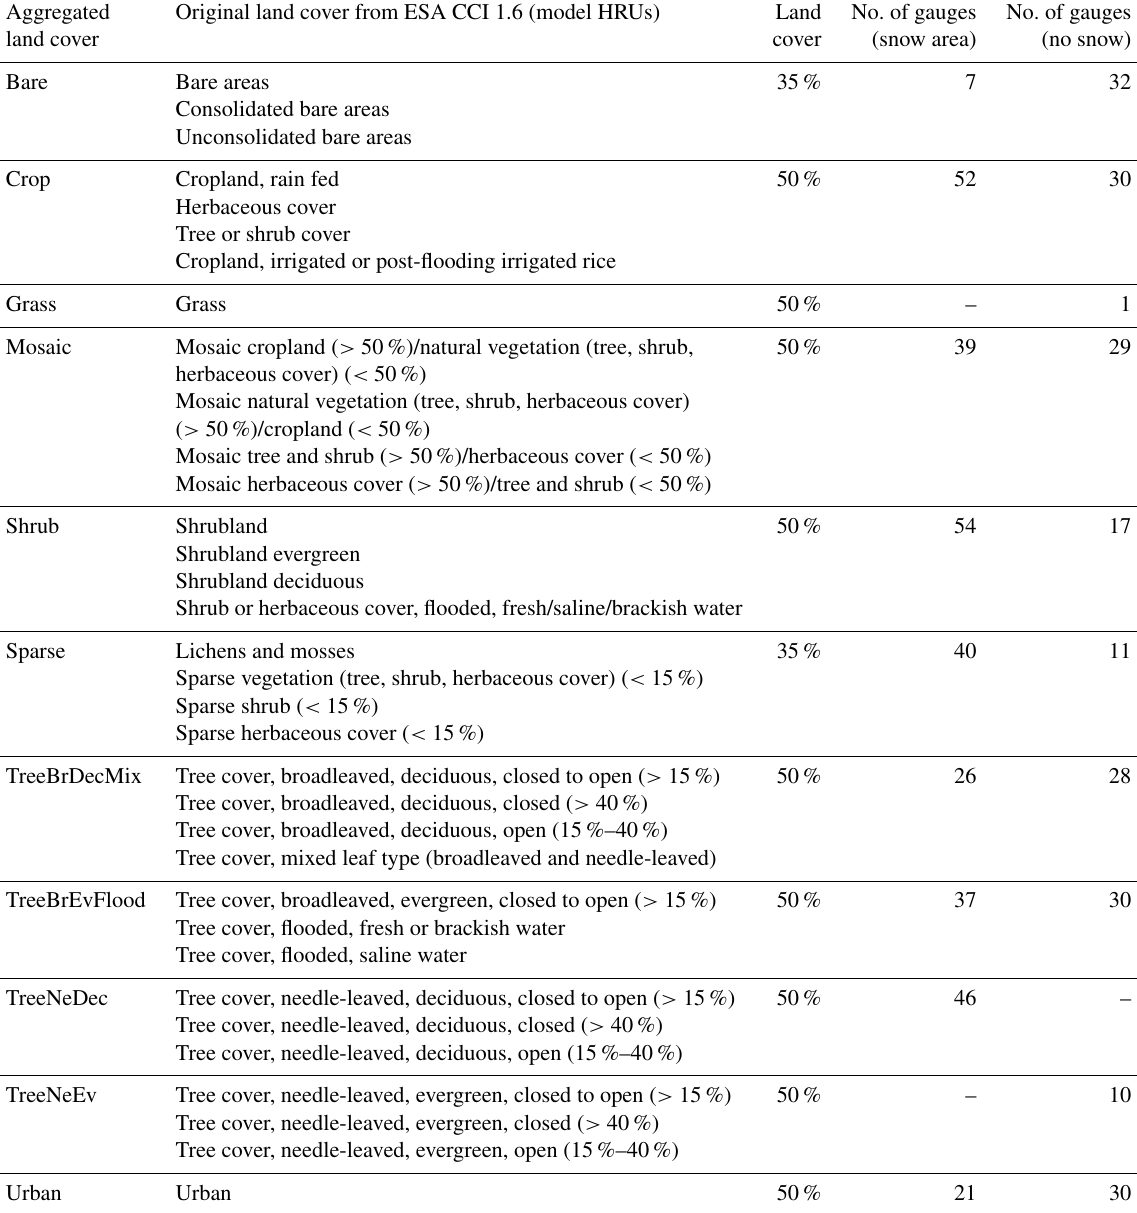
Table 4. Aggregated land covers used for calibrating HRUs, their representation in the upstream catchment, and the number of gauges available for each land cover when estimating parameter values of WWH